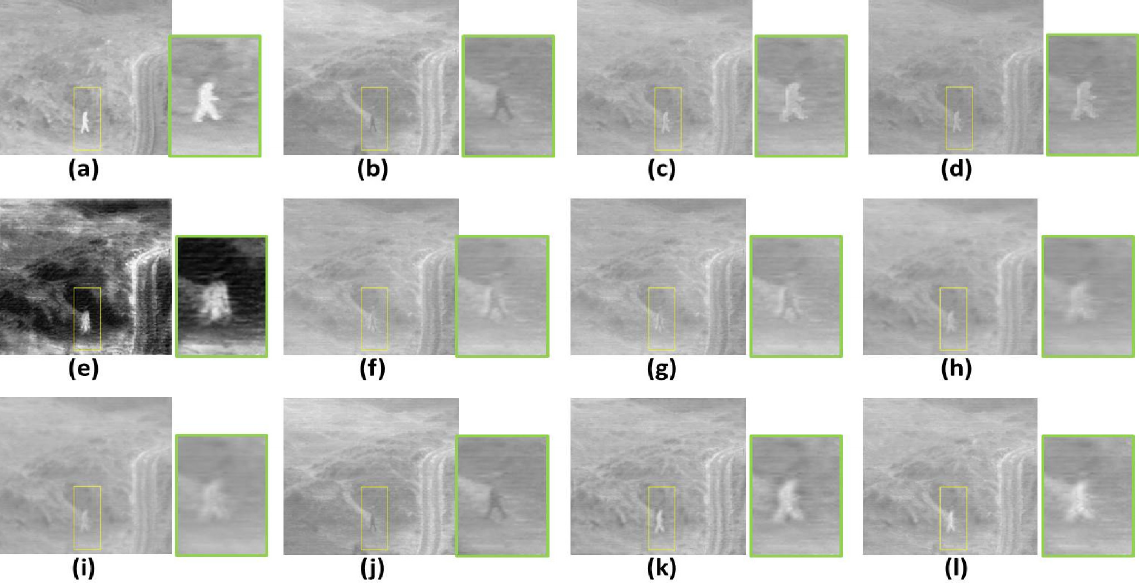
Figure 3. Visual IF results of different methods on duine sequence : ( a ) IR image, ( b ) VIS image,